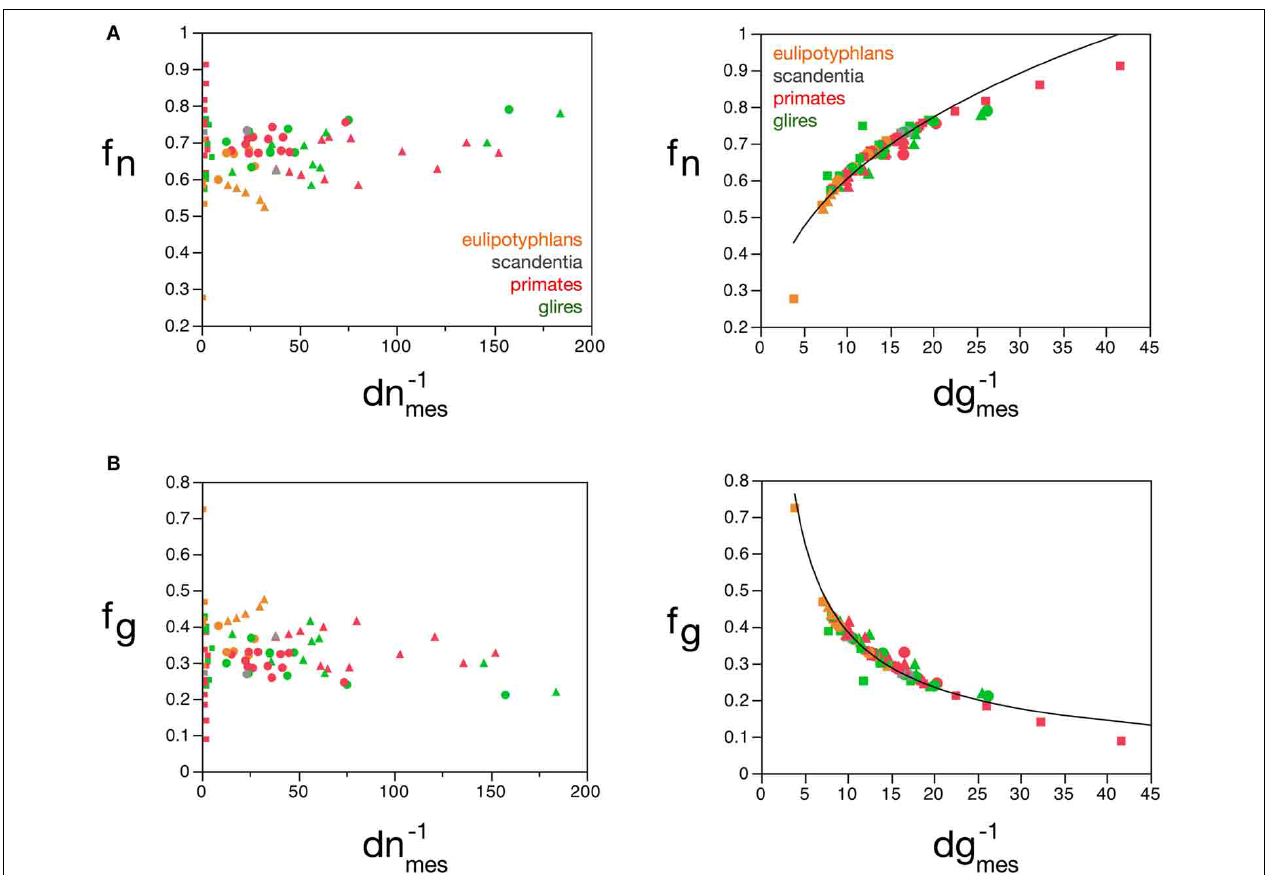
FIGURE 9 | Neuronal and glial mass fractions are well predicted by measured glial cell density. (A) Estimated neuronal mass fraction ( f n ) in each brain structure in each species is plotted as a function of the inverse of the measured neuronal density in the structure ( d − 1 nmes , left) and as a function of the inverse of the measured glial density in the structure ( d − 1 gmes , right). (B) Estimated glial mass fraction ( f g ) in each brain structure in each species is plotted as a function of the inverse of the measured neuronal density in the structure ( d − 1 nmes , left) and as a function of the inverse of the measured glial density in the structure